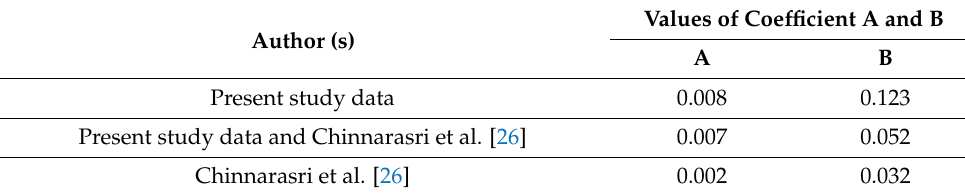
Table 4. Summary of coefficients used in different equations.